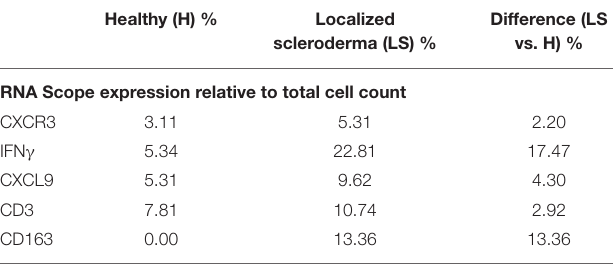
TABLE 6 | Immunofluorescent and RNAscope ® fluorescent multiplex imaging of localized scleroderma and control skin. Healthy (H) %